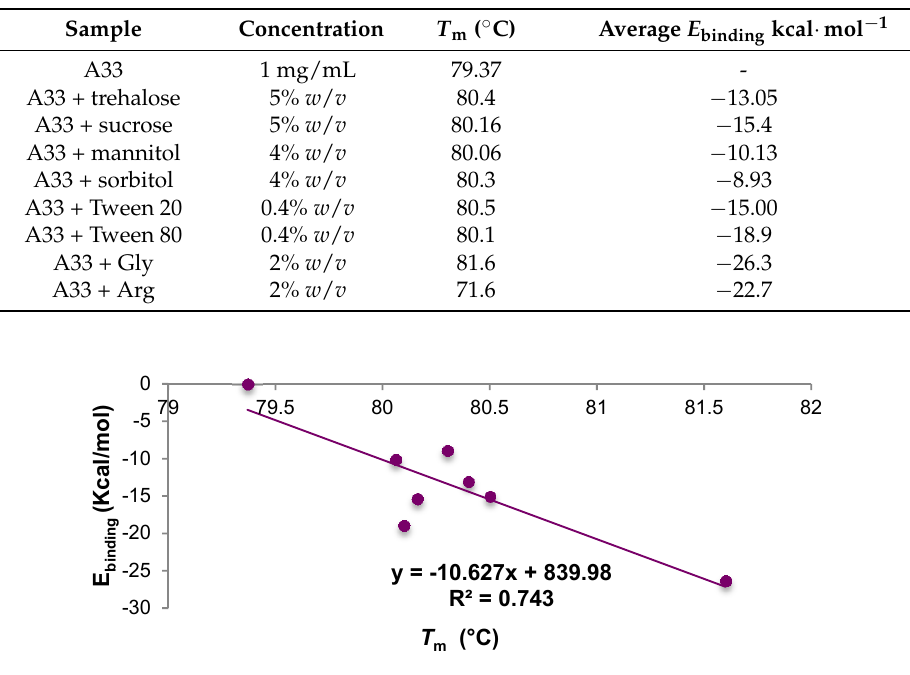
Table 6. T m values determined for Fab A33 with and without excipients. All experiments were performed in 10 mM phosphate buffer, pH 7; the average standard deviation was 0.28. Average binding affinity values from docking experiments above.